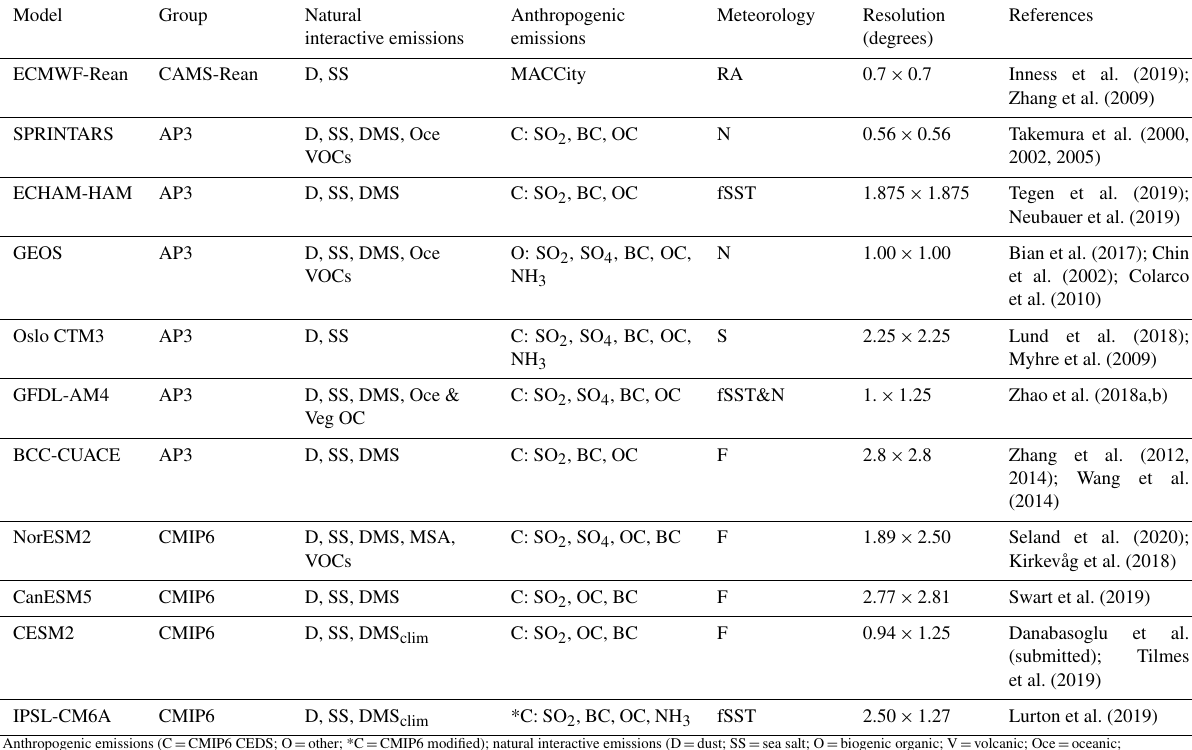
Table 2. Information on models used in this study (CAMS-Rean: CAMS reanalysis, AP3: AeroCom phase III, CMIP6: historical experiments from